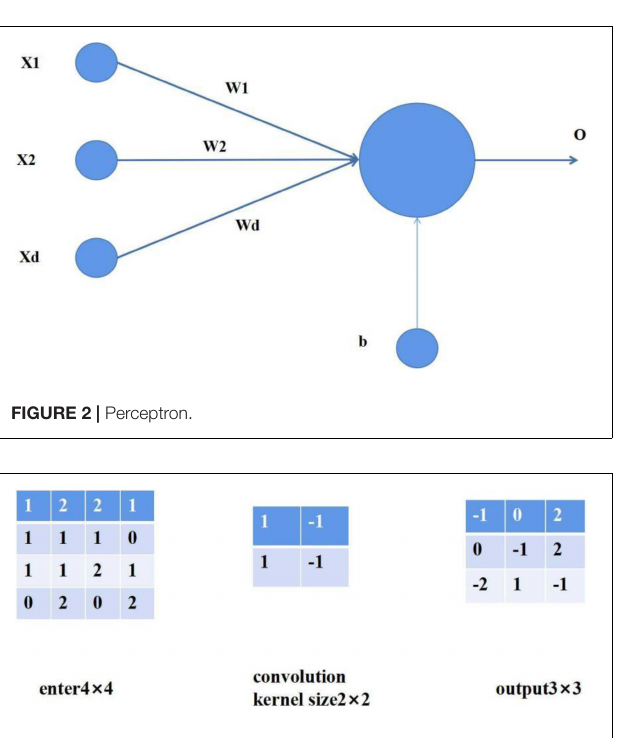
FIGURE 3 | Convolution operation.